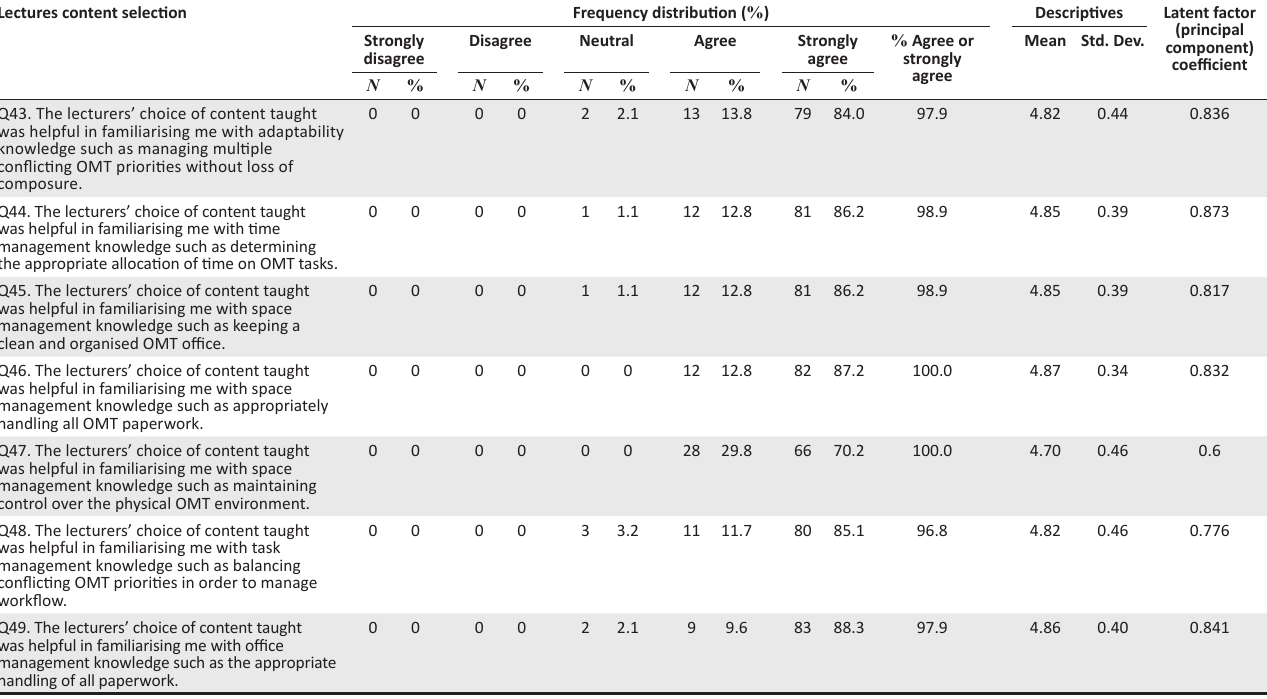
TABLE 7: Lecturers’ content